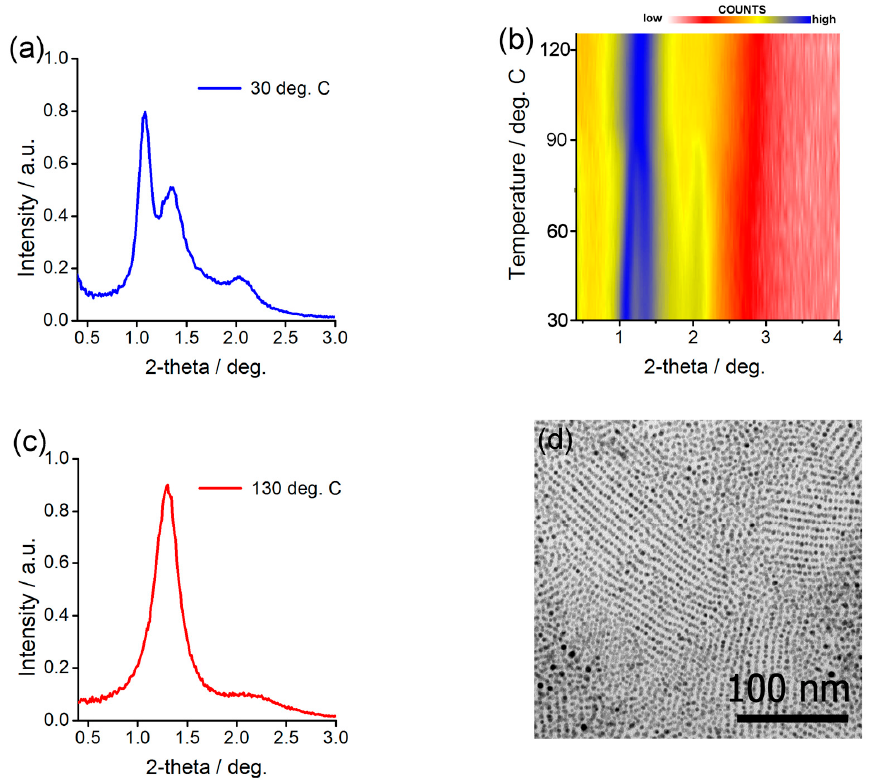
Figure 5. Structural investigation of Au@L1/C16 nanoparticles. ( a , c ) SAXRD profiles for low and high temperature structures (panels a, c, respectively) ( b ) Temperature evolution of SAXRD patterns taken for annealed sample and ( d ) corresponding TEM image.